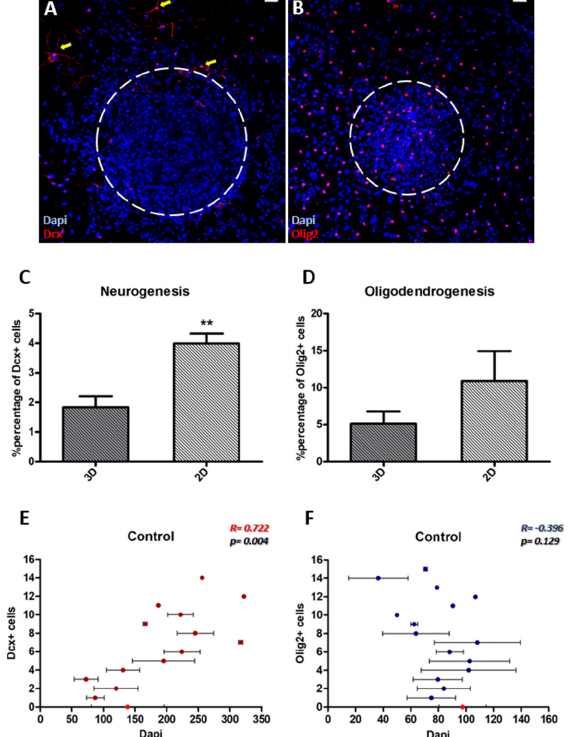
Figure 2. Neurogenesis is more dependent on the cytoarchitecture of the microenvironment than oligodendrogenesis. ( A , B ) Representative images of neurogenesis (Dcx+ cells) and oligodendrogenesis (Olig2+ cells) in polymorphic assays. Neuroblasts (indicated by yellow arrows) are detected mainly in monolayer areas but at the periphery of anchored neurospheres ( A ), while oligodendroblasts are more evenly distributed ( B ). ( C , D ) Graphs showing the comparison of percentages of Dcx+ and Olig2+ cells between 3D and 2D areas in polymorphic assays, with NSCs being cultured for 7d in differentiation conditions (** p < 0.01, using paired t -test, n = 5–6; Error bars: SEM). ( E , F ) Pearson correlation between the density of Dcx+ or Olig2+ cells and the total cell density, revealing a positive correlation for Dcx+ cells ( p = 0.004, r = 0.722, n = 5) ( E ) and no correlation for Olig2+ cells ( p = 0.129, r = − 0.396, n = 6; Error bars: SEM, with light red is indicated the average cell density in optical fields with no Dcx or Olig2 positive cells) ( F ). [Scale bars: 30 μ m].